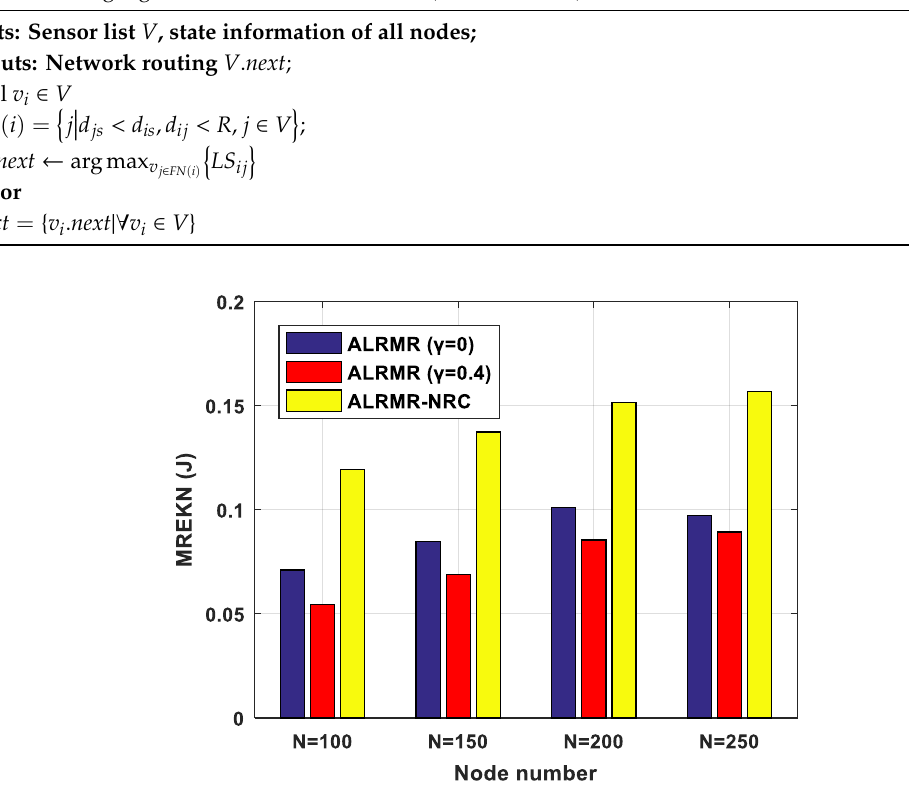
Figure 7. MREKN with different node numbers.